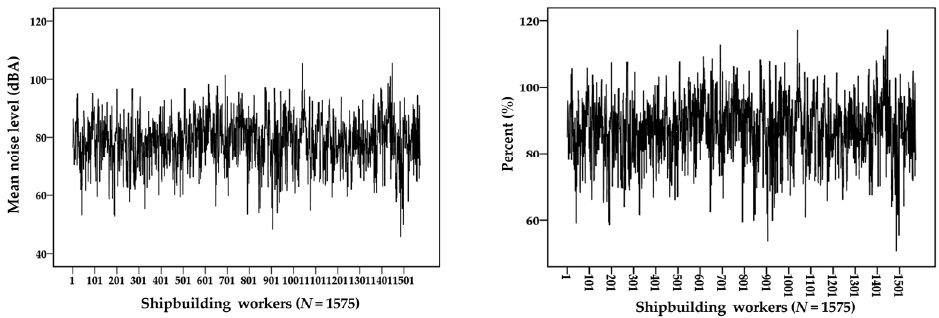
Figure 4. Mean noise levels and percent (%) for all subjects ( N = 1575) during the shipbuilding processes. Tables 5 and 6 show the comparative results for the mean levels of occupational noise exposure when excluding and including the break periods using the KOSHA guide and U.S. OSHA method. In the case of excluding the break period, the overall mean